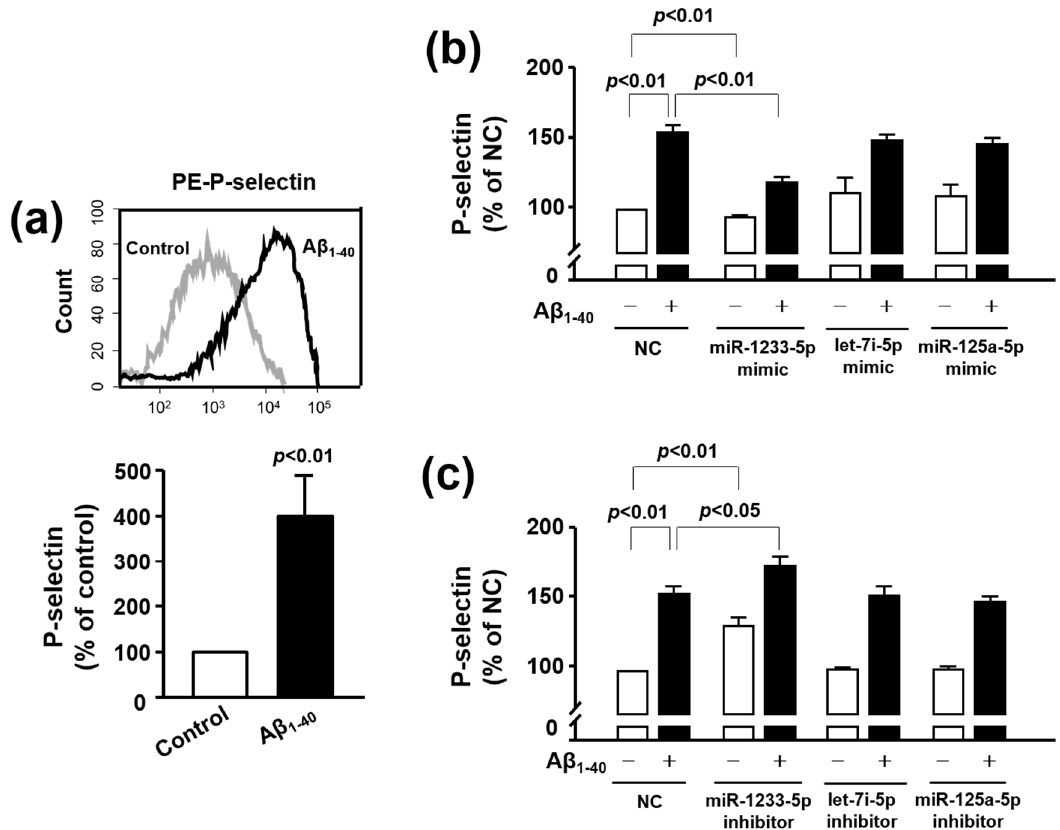
Figure 3. Role of let-7i-5p, miR-125a-5p, and miR-1233-5p in the A β 1-40 -induced P-selectin expression in platelets and MEG-01 cells. ( a ) Platelet activation status at basal level (gray curve) and after 10 µ M A β 1-40 stimulation (black curve) was monitored by flow cytometric measurement of PE-P-selectin expression. Data are mean ± SEM of six experiments. (b and c) Overexpression or inhibition of let-7i-5p, miR-125a-5p, and miR-1233-5p expression resulted in the alteration in the level of P-selectin in MEG-01 cells. Let-7i-5p, miR-125a-5p, and miR-1233-5p were individually overexpressed ( b ) or downregulated ( c ) using a specific mimic or inhibitor in MEG-01 cells after treatment with or without 10 µ M A β 1-40 for 1 h. P-selectin level was modulated in these samples as compared to that in samples treated with MEG-01 negative control (NC). Data are mean ± SEM of six experiments.